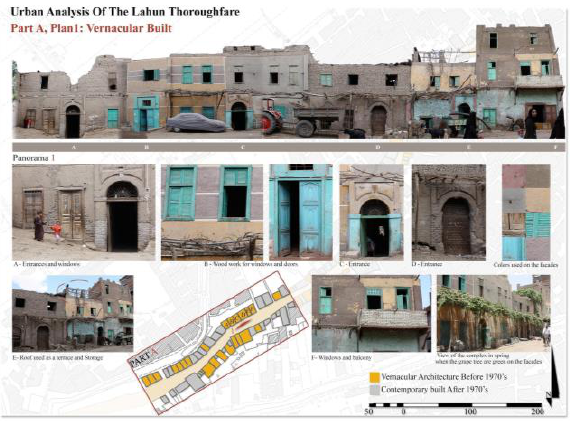
Figure 8. Pictures collage of some of the vernacular architecture in the main street of Lahun, © Author Image Copyright (2010).